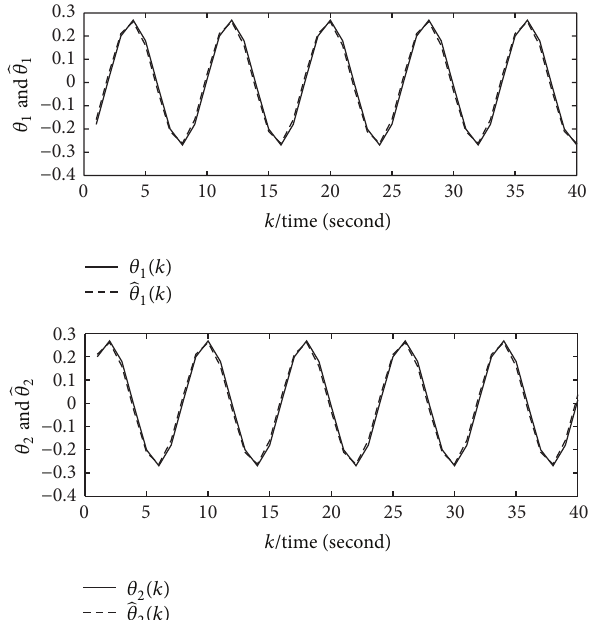
Figure 4: Curves of unknown parameters and parameters estima- tion.